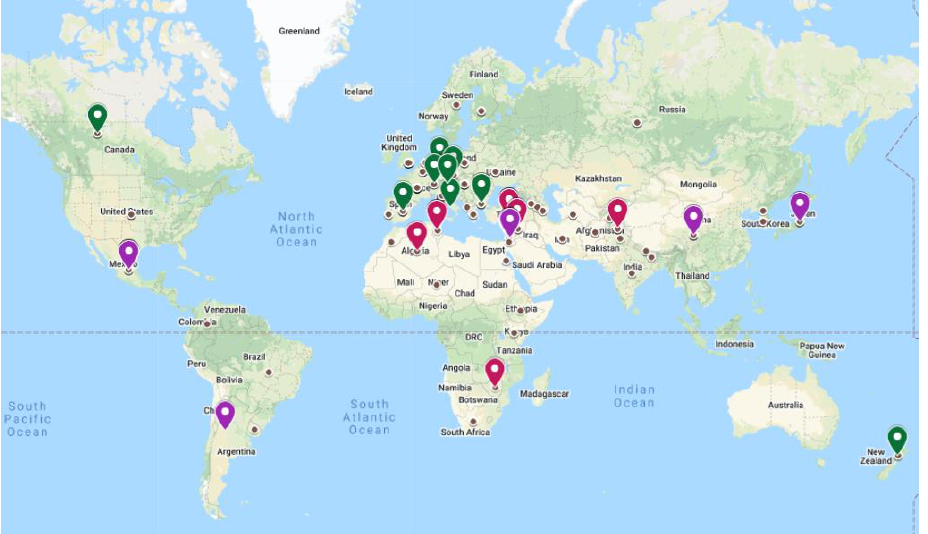
Figure 4. Geographic origins of the best performing accessions. Accessions with high GY in D (red); in D + W (purple); in W (green). The origins of the 232 accessions are marked as small brown circles. Under D, the maximum average of GY of (771.49 g/m 2 ± 59.88 g/m 2 ) was